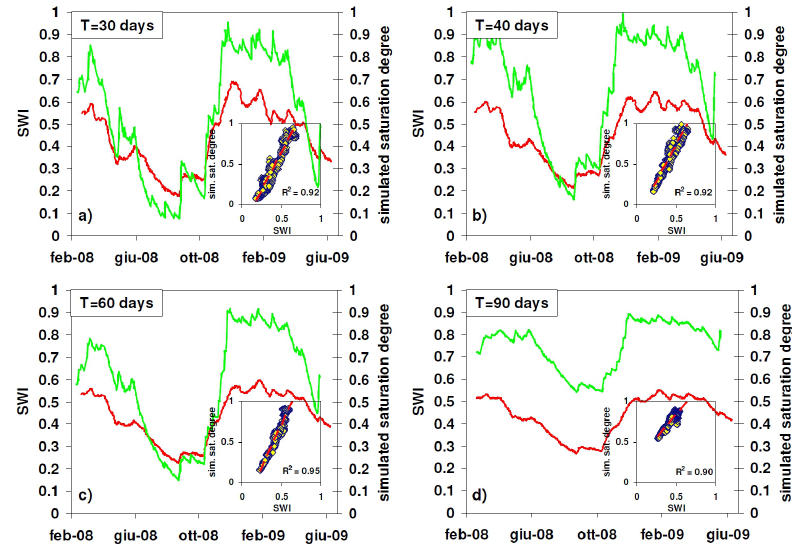
Fig. 2. – ASCAT Soil Wetness Index, SWI, versus simulated saturation degree for (a) TEV, (b) ASS, (c) NIC, and (d) TIM catchments. with the SWI index derived from the ASCAT pixel closest to the centroids of the catchment itself. The comparison between the SWI and SD mod is shown in Fig. 2 for four of the investigated